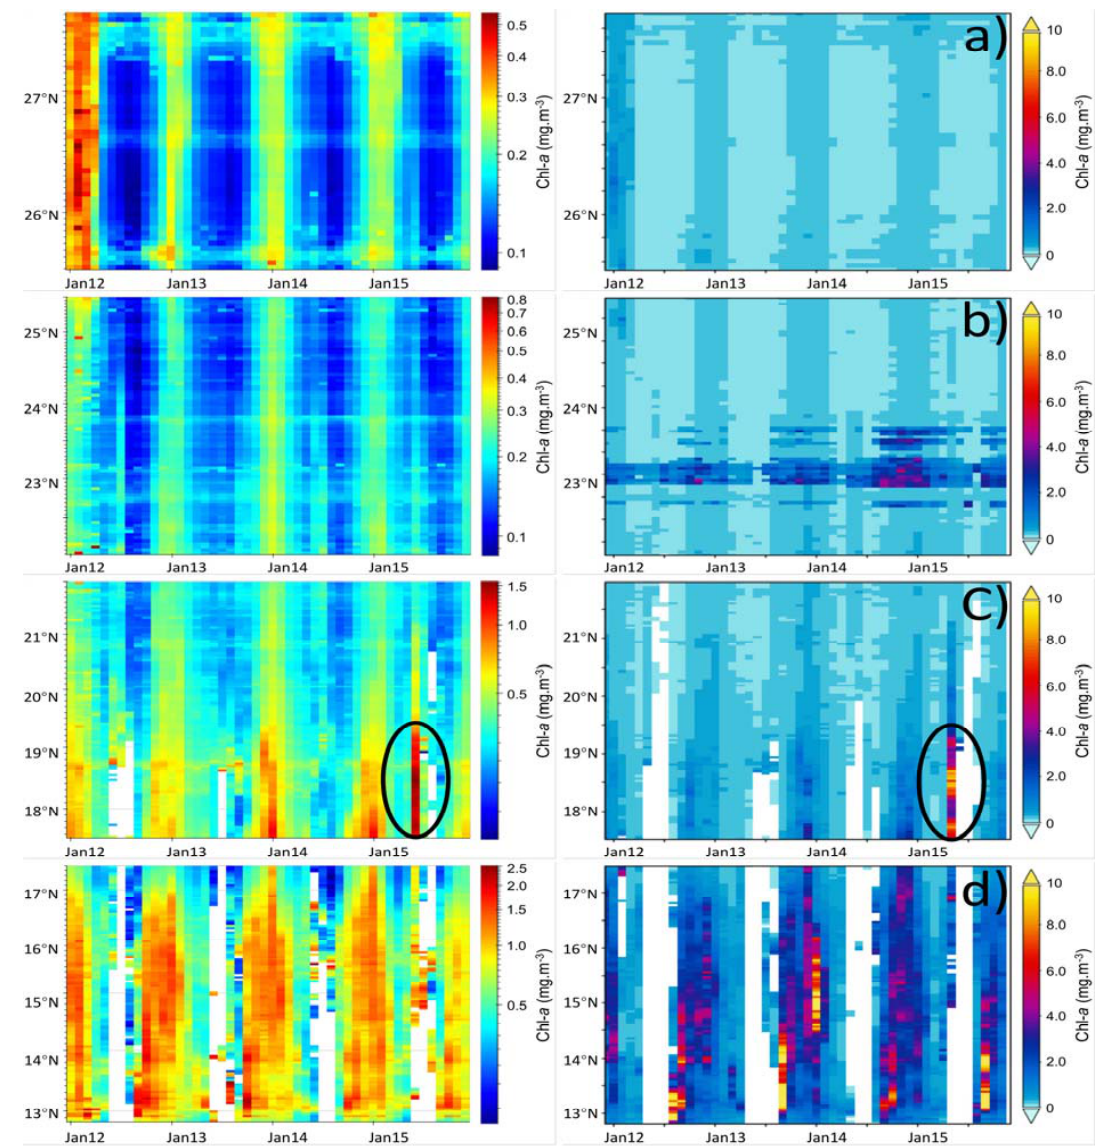
Figure 2. Hovmöller latitude-time plot for the four regions of Red Sea from January 2012 to December 2015. ( Left ) Chl- a (mg/m 3 ) merged Level-3 Ocean Color Climate Change Initiative (OC-CCI) 4 km monthly data, ( Right ) MODIS-Aqua Chl- a (mg m − 3 ) Level-3 4 km monthly data. The individual rows correspond to: ( a ) Northern Red Sea (NRS) ( b ) North Central Red Sea (NCRS) ( c ) South Central Red Sea (SCRS) ( d ) Southern Red Sea (SRS). Note the difference in the scales between the left and right sets of panels.